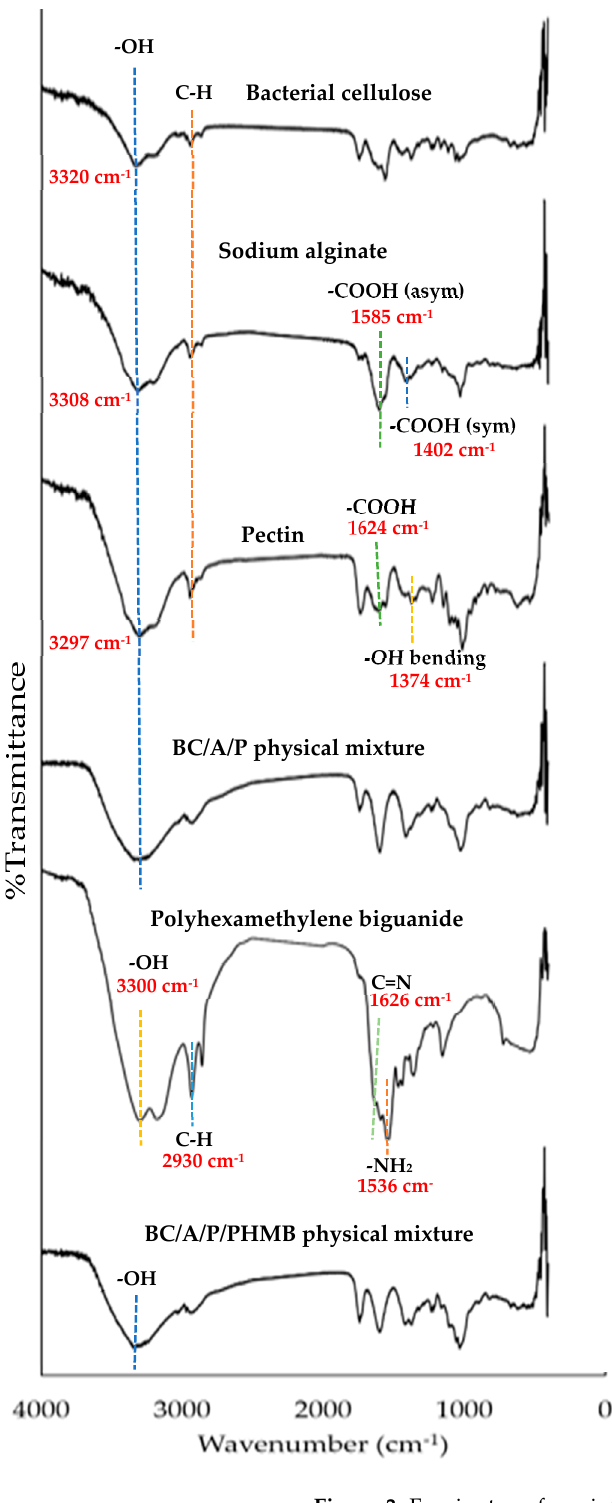
Figure 3. Fourier-transform infrared spectroscopy (FTIR) spectra of A, P, BC, a physical mixture of A, P, and BC with or without PHMB and bacterial cellulose composite sponge